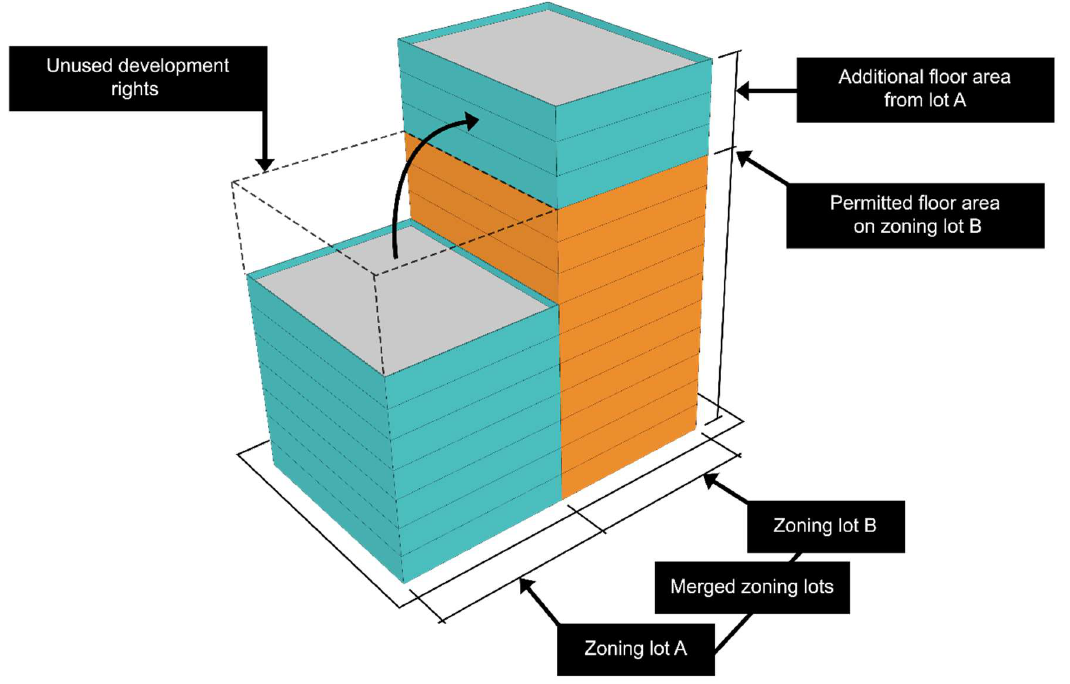
Figure 4. Plot mergers (illustration sourced by authors).